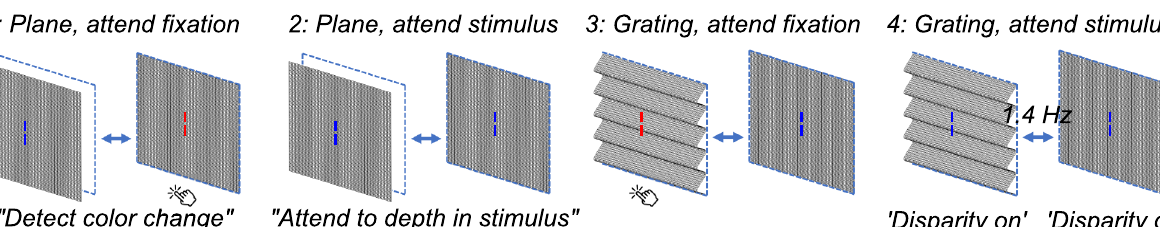
Figure 1. ( a ) Top-down schematic illustration of absolute and relative disparity. Fixation point N (nonius lines) is on the zero-disparity plane defined by the horopter (green Vieth-Muller circle). Point 1 (purple) is also on the horopter and angles α L and α R are equal, meaning that the absolute disparity given by α L − α R is zero. Point 2 (orange) is either on a second plane (dotted line) or on the peak of a disparity grating (sinusoidal line). At point 2, the absolute disparity, β L − β R , is non-zero. The relative disparity between points 1 and 2 is the difference between the two absolute disparities, ( α L − α R ) − ( β L − β R ) . In contrast to the absolute disparity, the magnitude of the relative disparity is independent of fixation. ( b ) Random-dot stereopair used in the main experiment depicting a sinusoidal disparity grating (crossed disparity when cross-fused). The dots in the actual experiment were dynamic. ( c ) Schematic of different stimuli, task conditions, and temporal modulation between crossed disparity, ‘disparity on’, and zero disparity, ‘disparity off’ phases. Participants were asked to detect a brief color change on the fixation lines, or to attend to the depth modulation of the stimulus, for either plane (absolute disparity only) stimuli or grating (absolute and relative disparity) stimuli. To generate a visual-evoked potential, all stimuli modulated between disparate and non-disparate states at 1.4